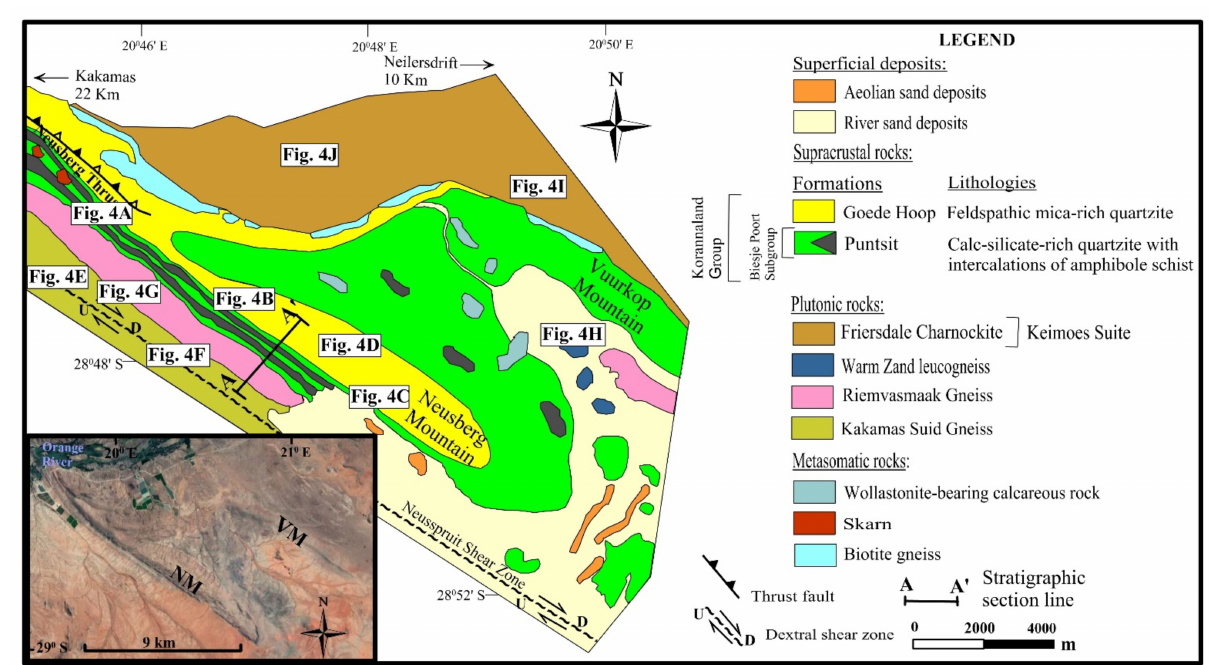
Figure 3. Geological map of the Neusberg Mountain showing the location of various rock types within the study area and its position within the Kakamas Domain of the Namaqua Sector, South Africa. Inset of the satellite image displaying the entire extent of the Neusberg Mountain in the study